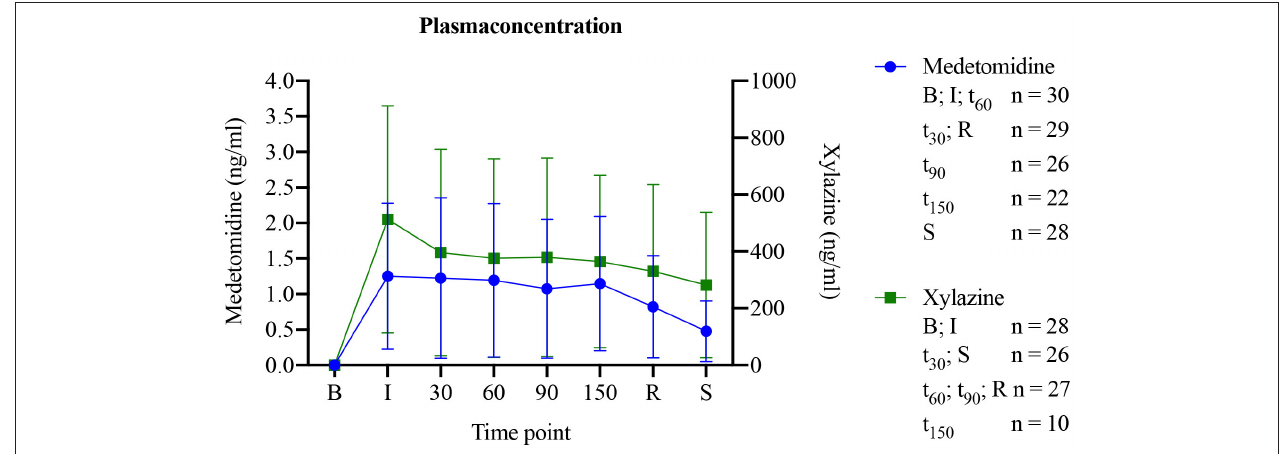
FIGURE 3 | Medetomidine or xylazine plasma concentrations in horses before, during and following medetomidine isoflurane (group MED) or xylazine isoflurane (group XYL) balanced anesthesia (mean ±